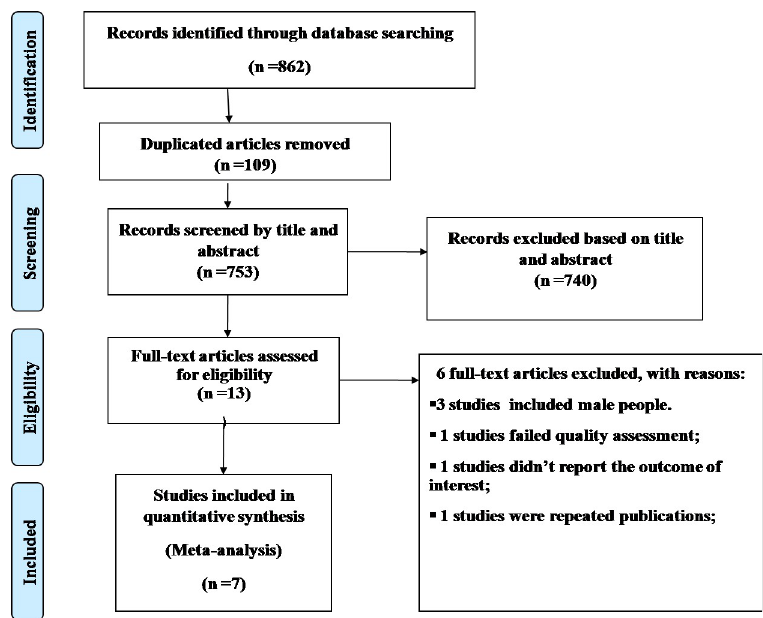
Fig 1. PRISMA flow diagram of the included studies for meta-analysis of unmet need for family planning among reproductive-age women living with HIV in Ethiopia.